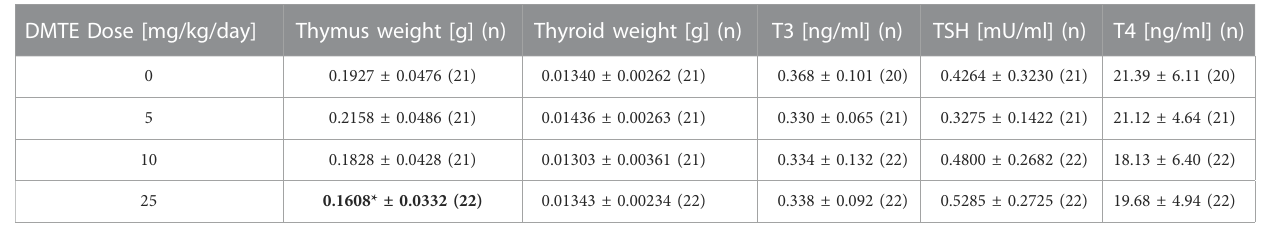
TABLE 2 Maternal thymus and thyroid data of rats exposed to DMTE.